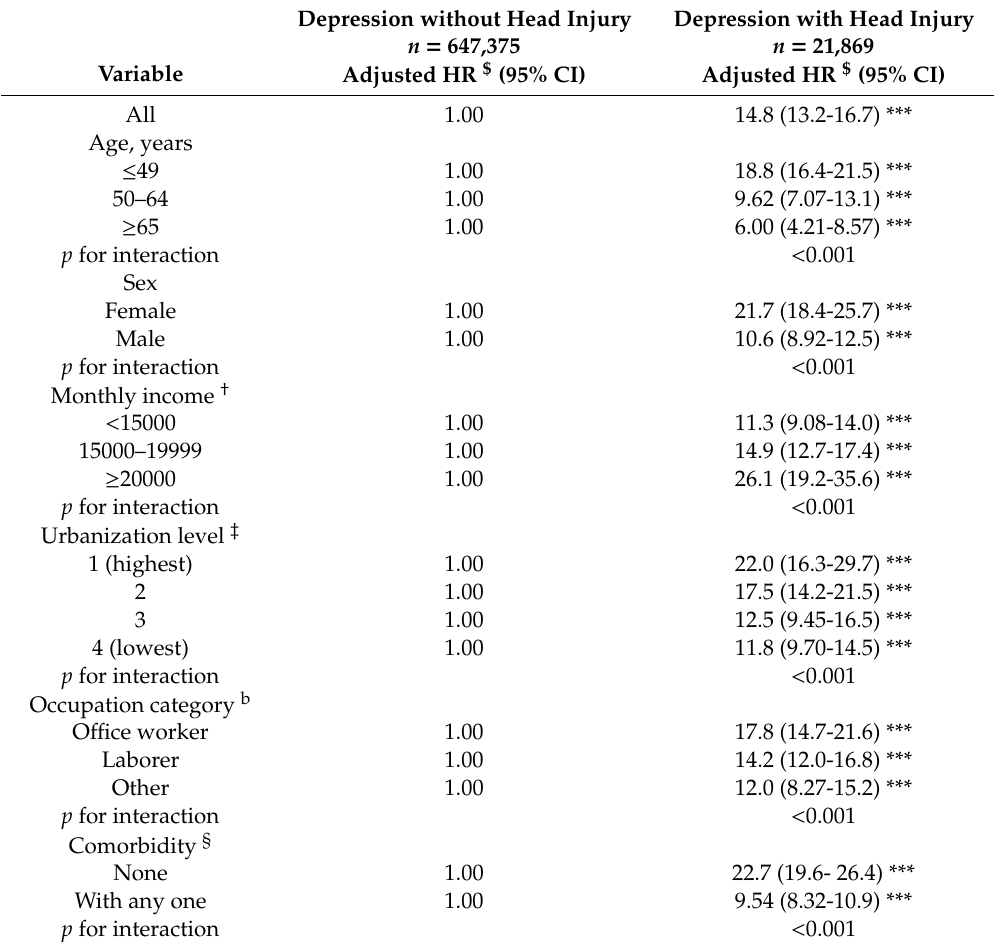
Table 4. Comparison of incidences and hazard ratios for suicide attempt stratified by age, sex, and comorbidities between patients with depression with and without head